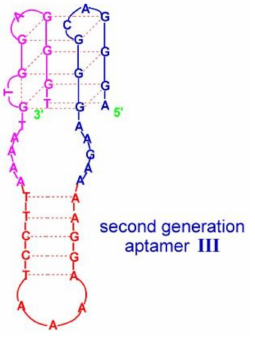
Figure 17. Schematic structure of quadruplex–hairpin junction with peroxidase-like activity [58]. Reproduced under the Creative Commons Attribution